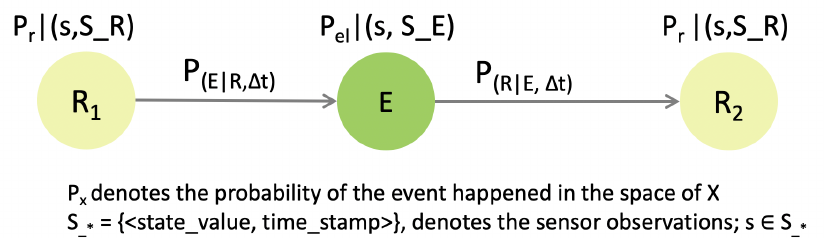
Figure 6. The FSM model for presenting the state transition of elevator.